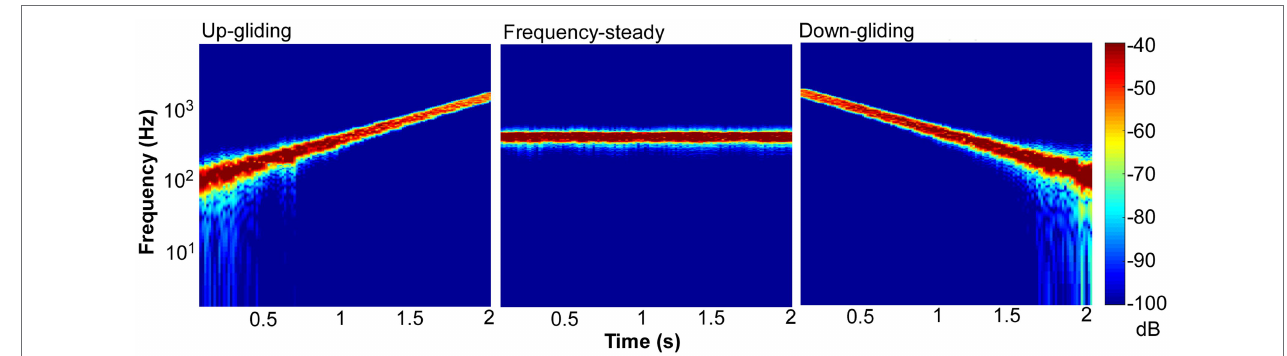
FIGURE 1 | Spectrograms of up-gliding, frequency-steady, and down-gliding